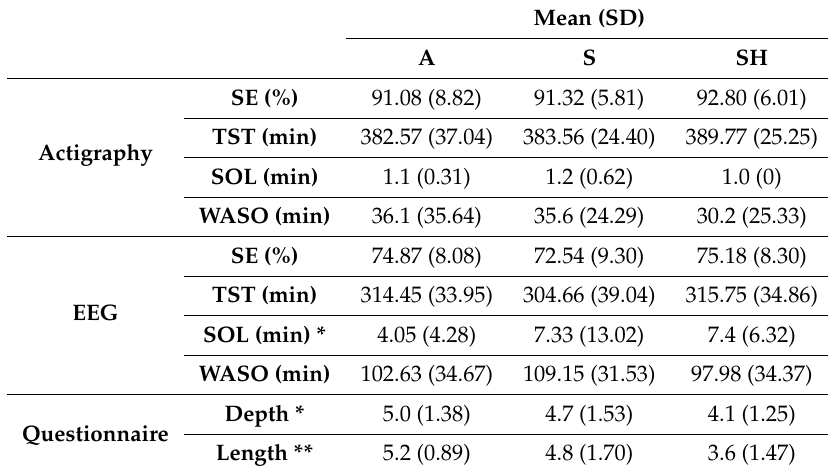
Table 2. Sleep efficiency (SE), total sleep time (TST), sleep onset latency (SOL), and wake after sleep onset (WASO) via the actigraphy signal analysis and the EEG signal analysis.